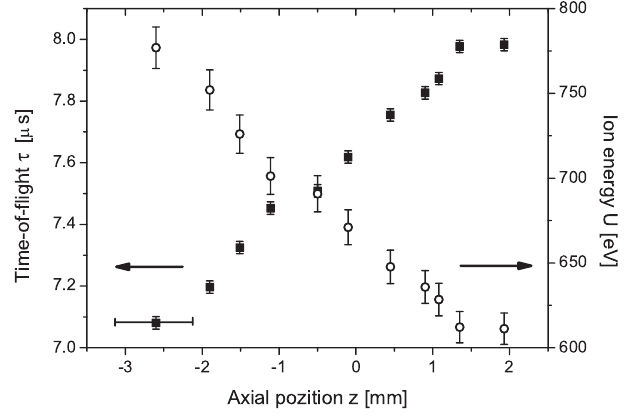
FIG. 9. Ion time-of-flight (cid:2) (left axis) and energy (cid:11) (right axis) versus axial position at an acceleration voltage of 1.36 kV. The systematic uncertainty in z (cid:5) 0 : 5 mm is represented for a single point (left